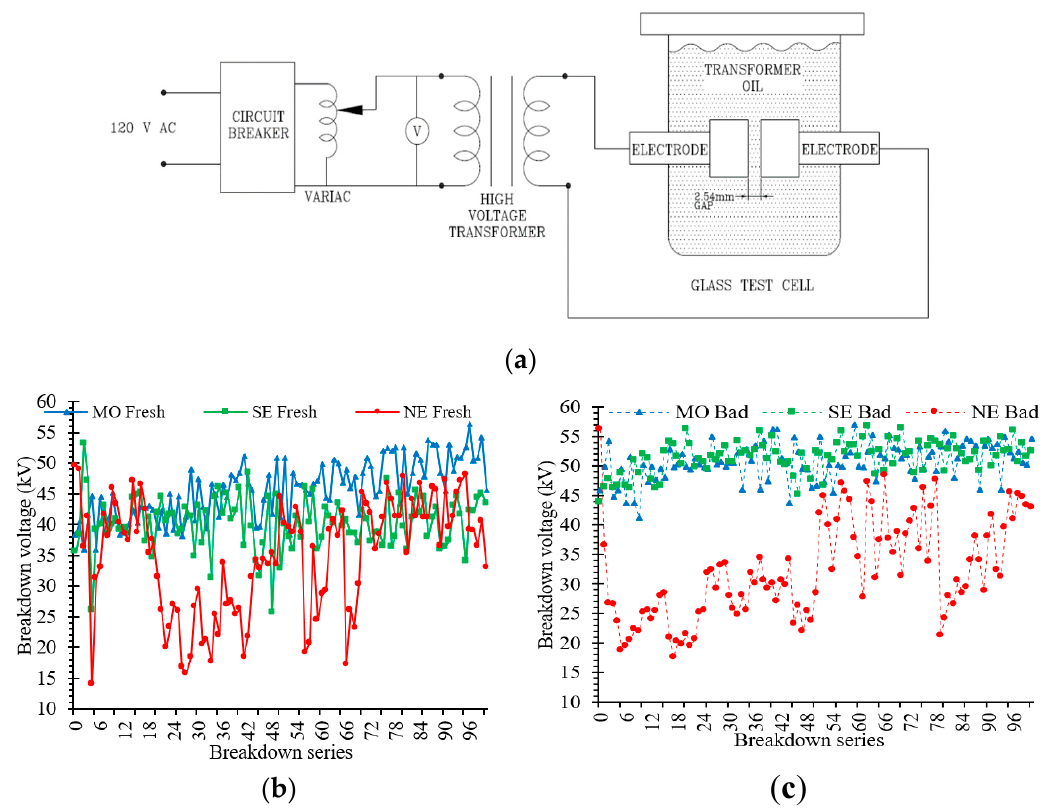
Figure 1. Experimental of the arcing fault in various dielectric fluids; ( a ) test set up used for arcing; ( b ) 100 BDV series for fresh insulating liquids; ( c ) 100 BDV series for aged insulating liquids.